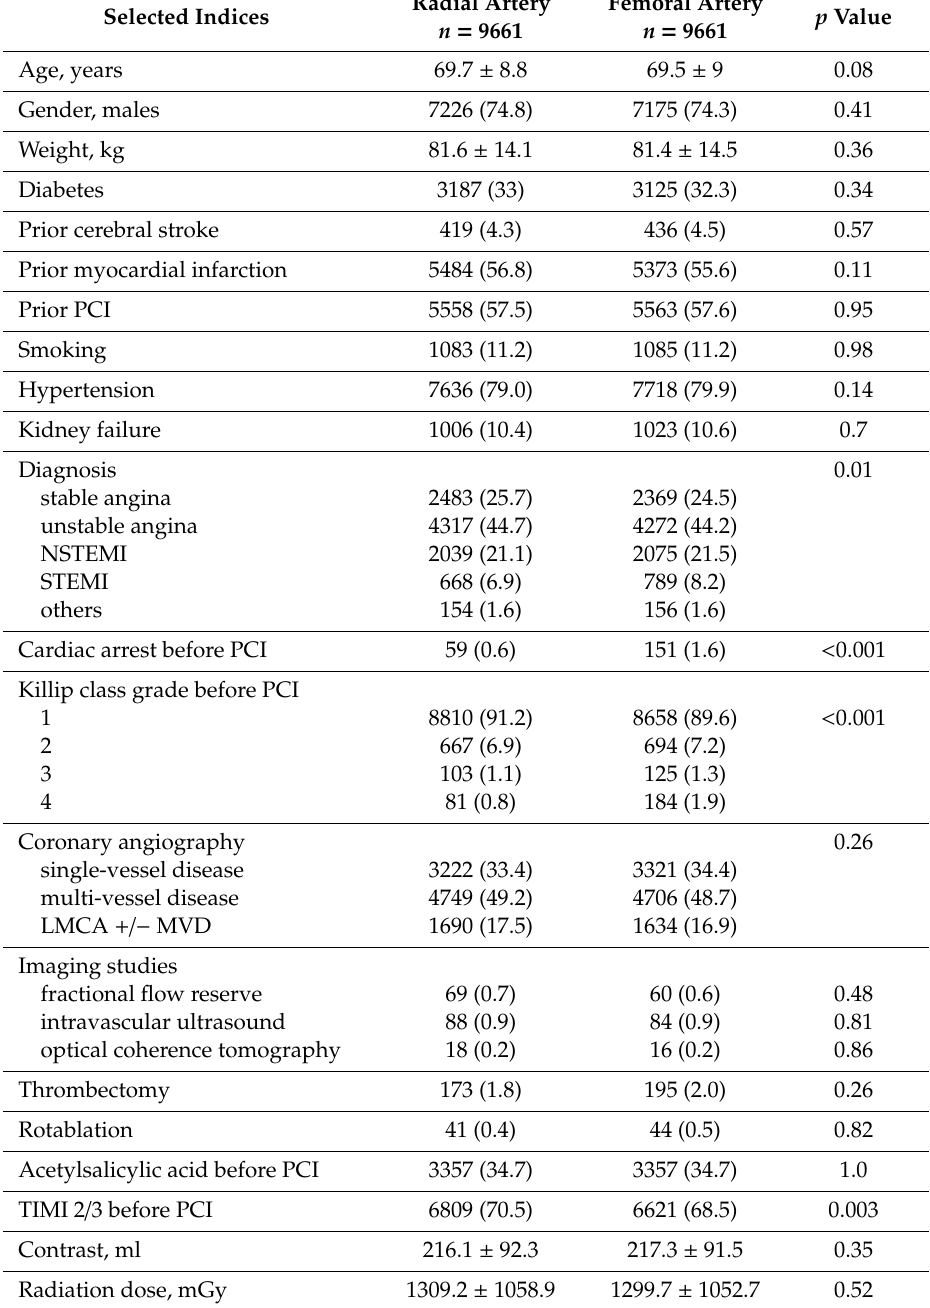
Table 3. General patient characteristics according to radial and femoral access in the overall group of patients following propensity score matching after inclusion in Killip class grade and cardiac arrests at